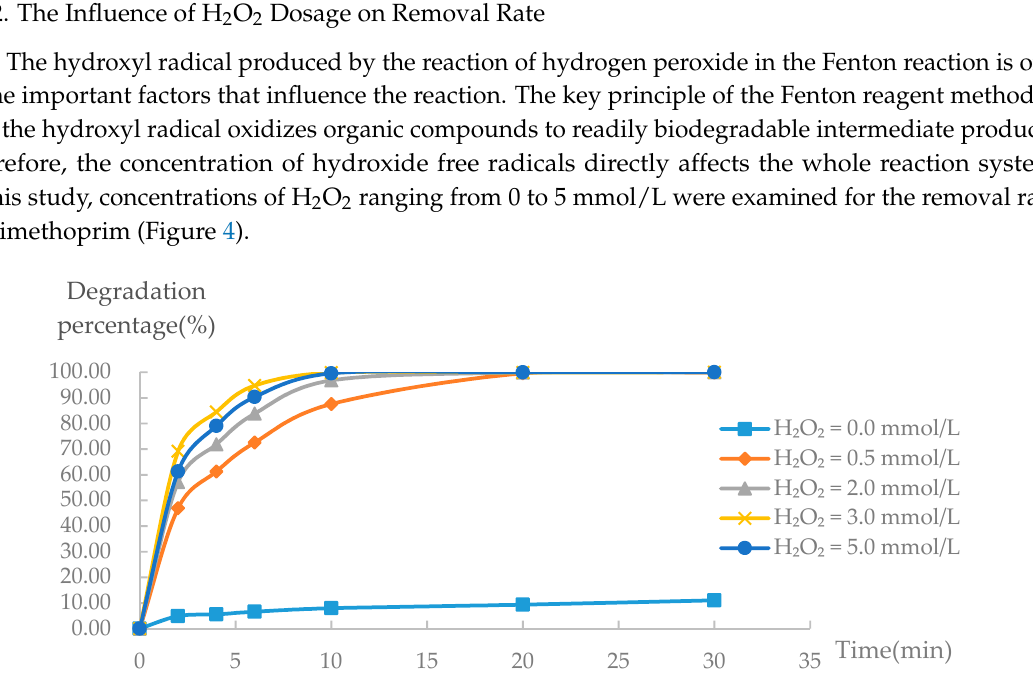
Figure 3. The influence of pH (2.5–4.5) on the degradation of trimethoprim.